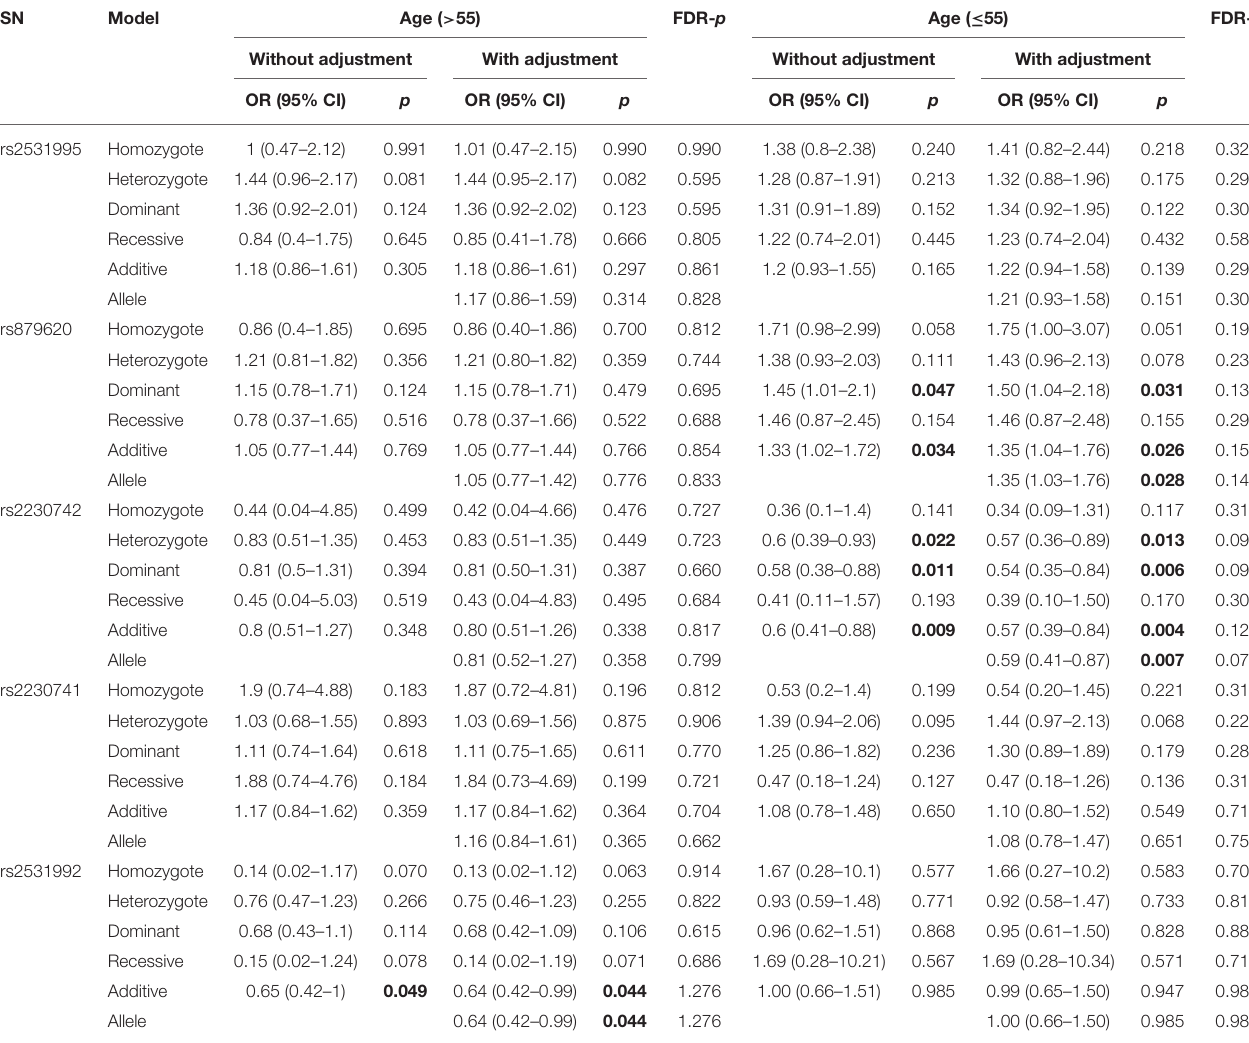
TABLE 4 | The association between ADCY9 gene polymorphisms and hepatocellular carcinoma risk in subgroup of age.